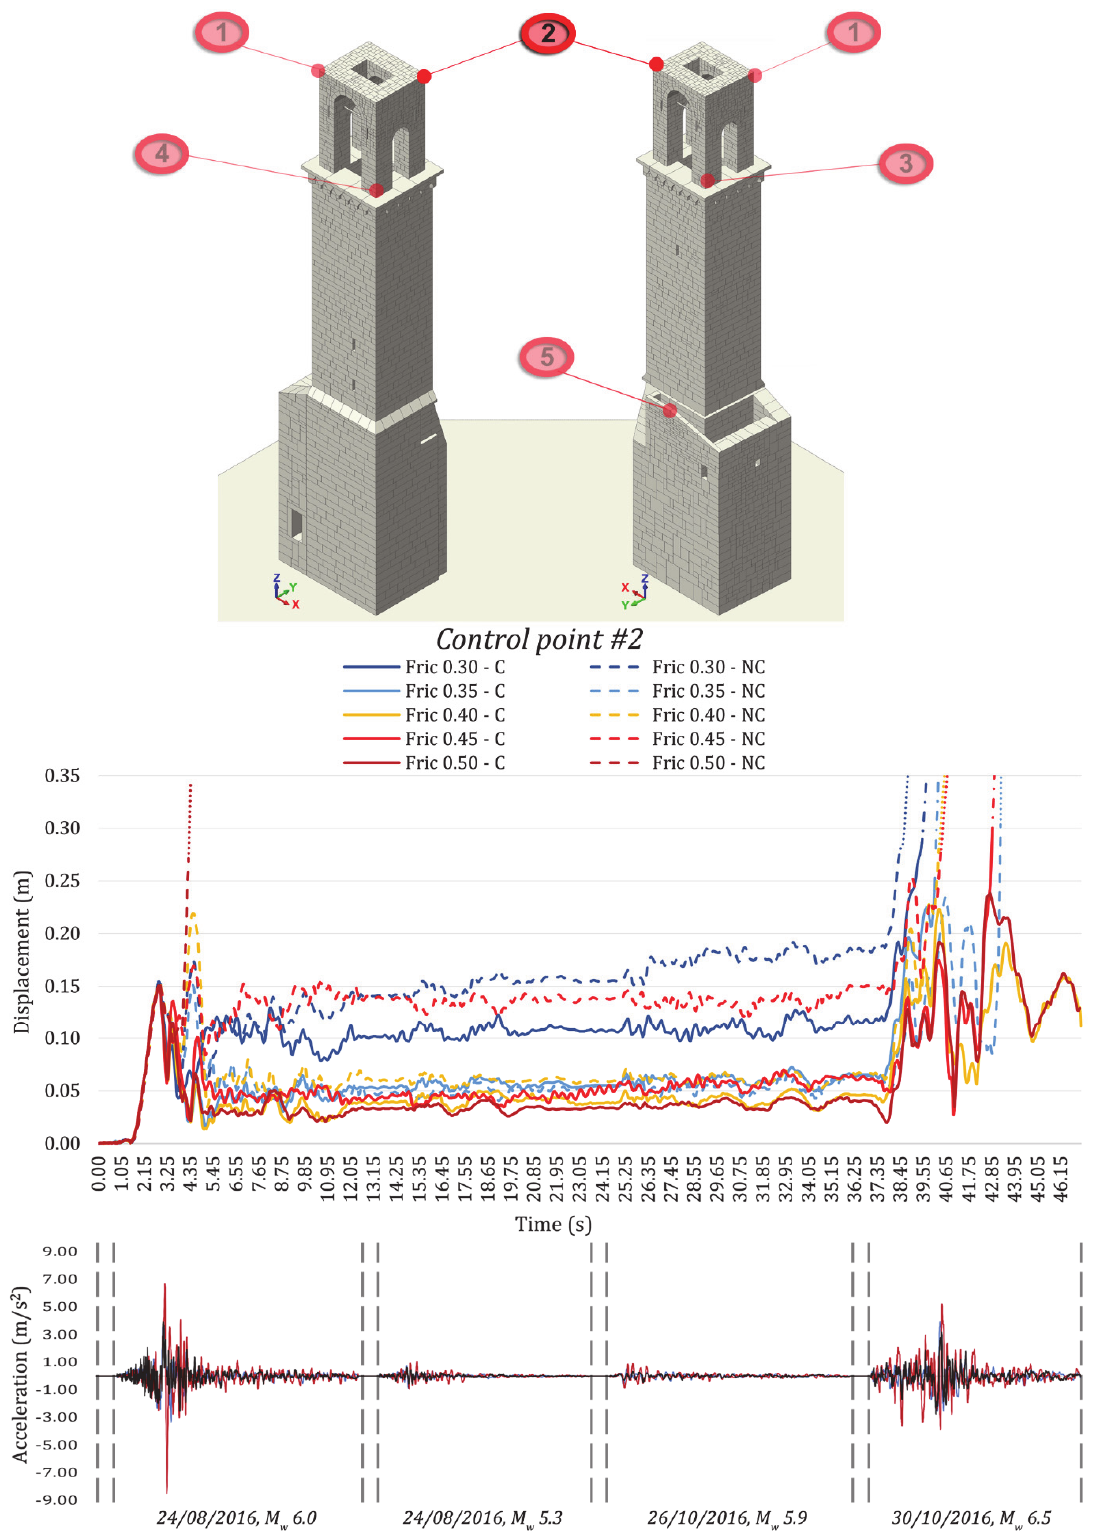
Figure 17: Displacements time histories of the control point #2 of the civic clock tower of Amatrice (Rieti, Italy) under the four main shocks in the three components x,y,z recorded in the village during the Central Italy seismic sequence of 2016 for both configurations, with (namely C) and without (NC) the steel chains, at varying of the friction on the bell